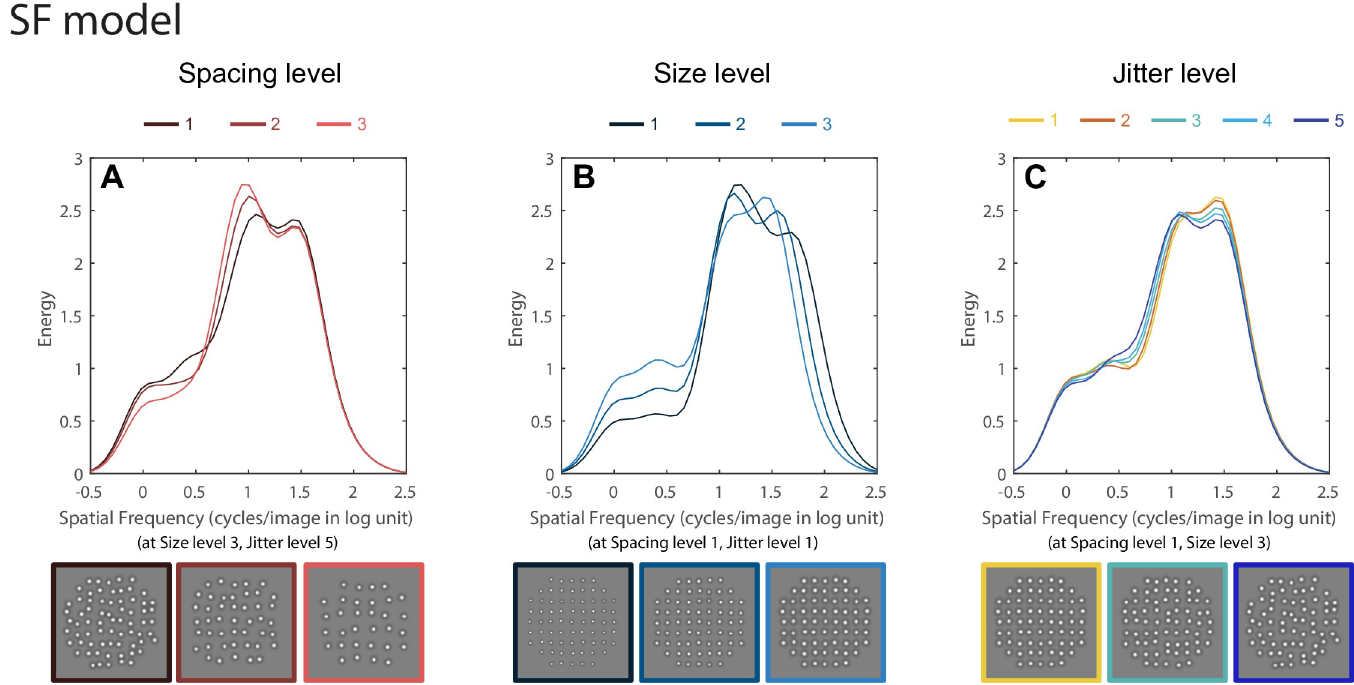
Fig 8. Gabor wavelet analysis results for the SF-distribution model. Each stimulus image from the experimental conditions (examples shown at the bottom) was filtered by a set of oriented Gabor filters (12 orientations, 0–165 degree, with a 15-degree interval) with a wide range of spatial frequencies (50 log-spaced SFs from 0.23 to 512 cycles per image). The pixelwise root-mean-square (RMS) responses (i.e. energy) of each filtered image was then calculated and normalized by the square of the filter size, and then averaged across orientations. The RMS responses are plotted as energy (ordinate) as functions of spatial frequency (abscissa). In (A), we plotted the analysis results for the three element spacing levels (from dark to light red lines) at size level 3 and jitter level 5 conditions, as other size and jitter combinations all show a similar pattern shift of the SF distribution with spacing–the highest peak shifts to the left. In (B), the analysis results for the three element size levels at spacing level 1 and jitter level 1 conditions are plotted with dark to light blue lines. Other spacing and jitter combinations also show a similar pattern shift of the SF distribution with size–the second highest peak shifts to the left. (C) depicts the SF distributions of five jitter levels (from yellow to blue lines) at spacing level 1 and size level 3 conditions. As shown in (C) and in our earlier study [7], higher regularities (i.e. lower jitter levels) make the SF distribution sharper while lower regularities (i.e. higher jitter levels) make the SF distribution flatter, though these effects are small for the stimuli used here. Other spacing and size combinations also give similar changes in the SF distribution.